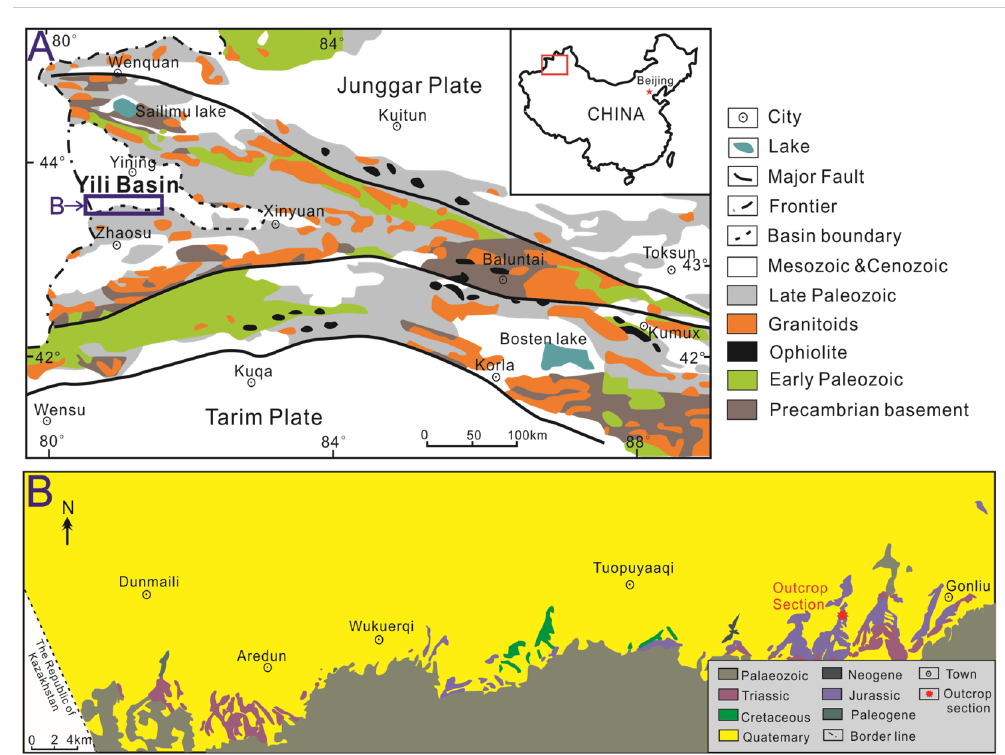
Figure 1. ( A ) Tectonic location of the Yili Basin with Paleozoic tectonic features; ( B ) Geological map of the southern Yili Basin (redrawn from [39]).